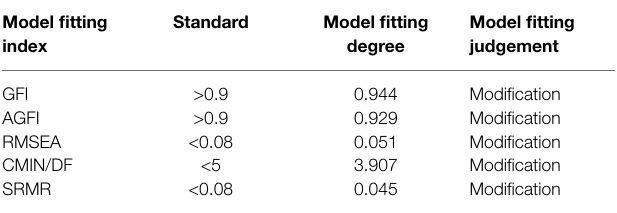
TABLE 3 | Index table of model fitness. Model fitting